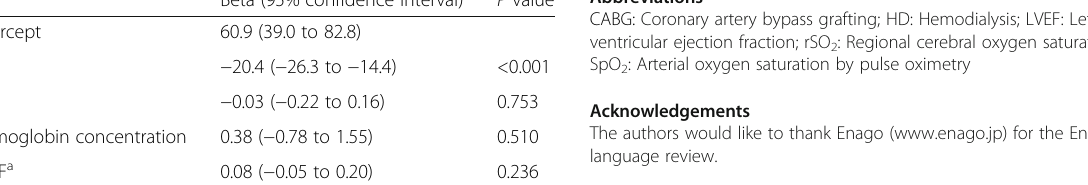
Table 2 Multivariable linear regression analysis for the association of HD and rSO 2 , adjusting for age, hemoglobin concentration, and LVEF Beta (95% confidence interval) P